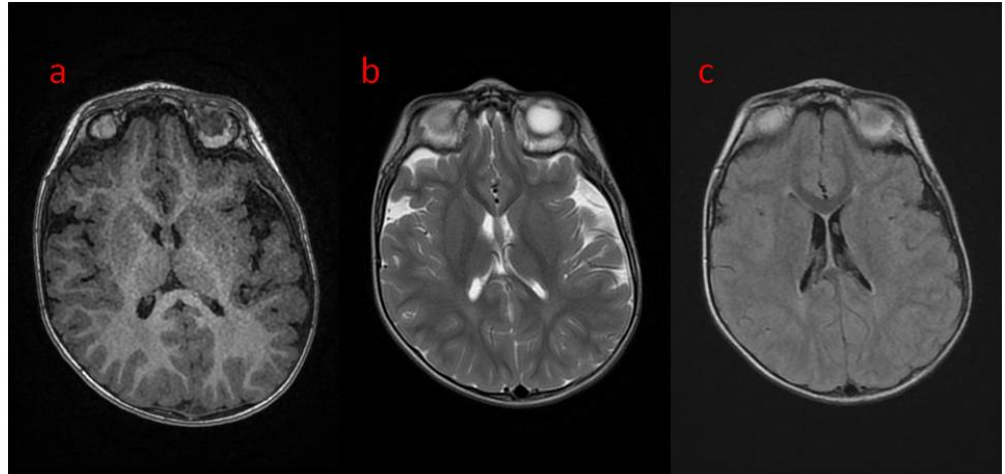
Figure 1. ( a – c ) Brain MRI in transverse planes: ( a ) normal in T1; ( b , c ) unfished myelinisation in peritrigonal white matter in ( b ) T2; ( c ) T2 FLAIR.